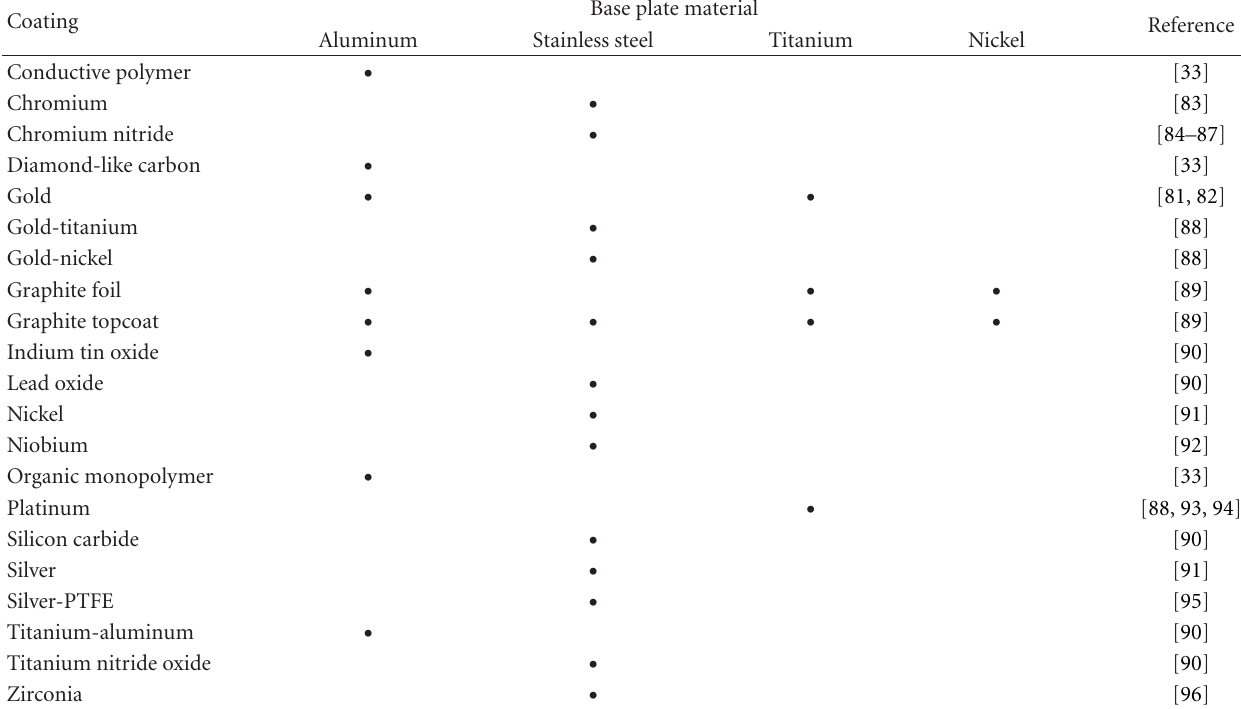
Table 2: Potential coating materials for metallic bipolar